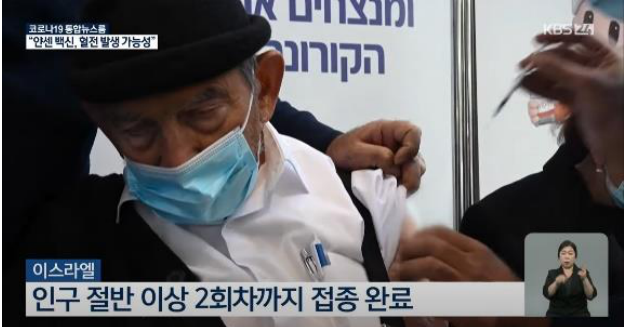
Figure 22. Example of the current sign language interpreter size in TV broadcasts. Table 10. Basic conditions for information delivery component layout design for DHH